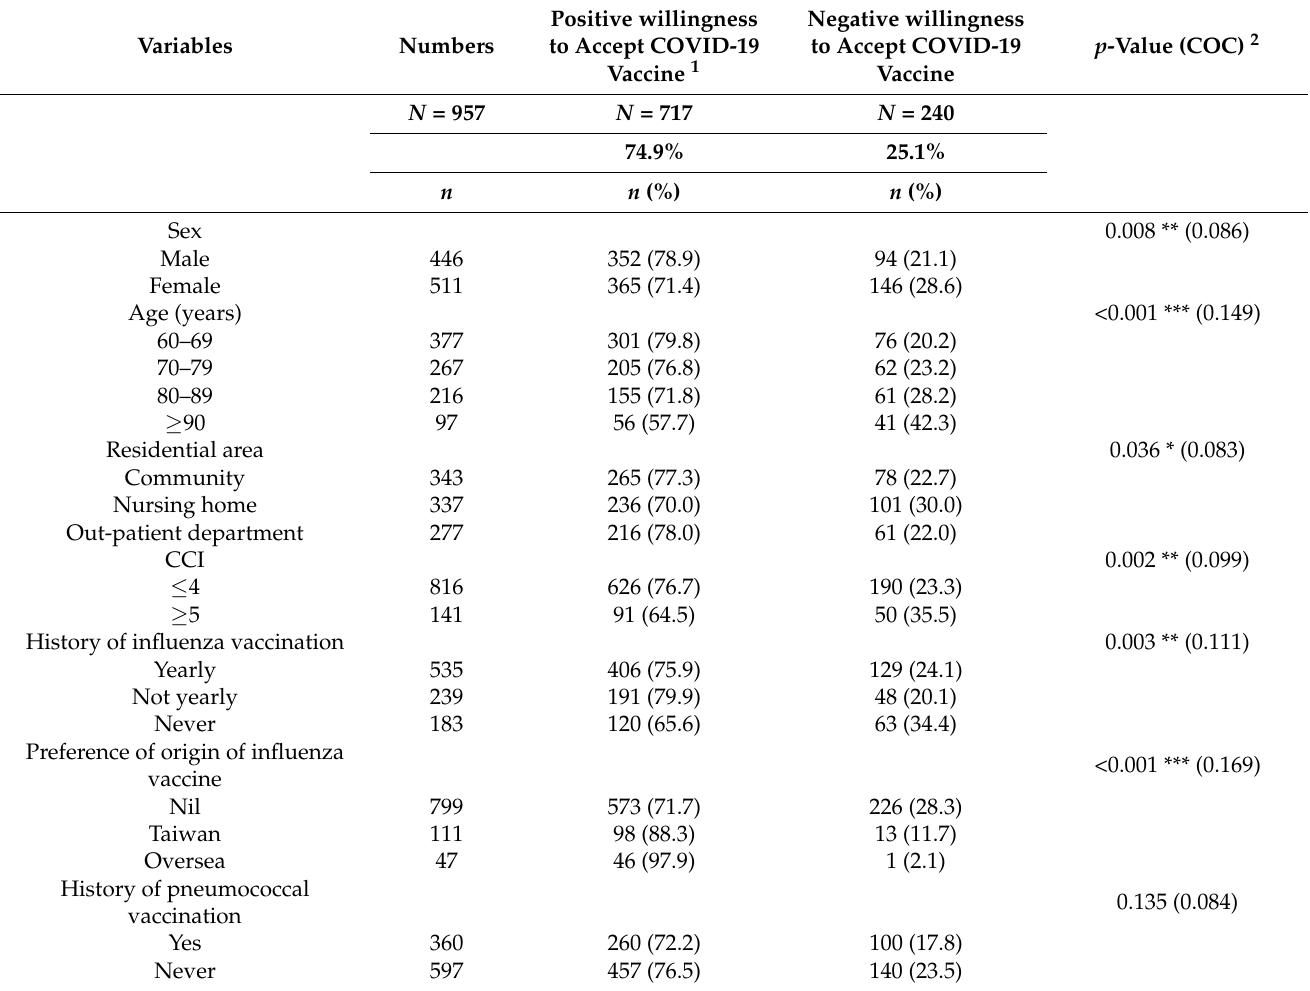
Table 1. Basic characteristics of the participants stratified by